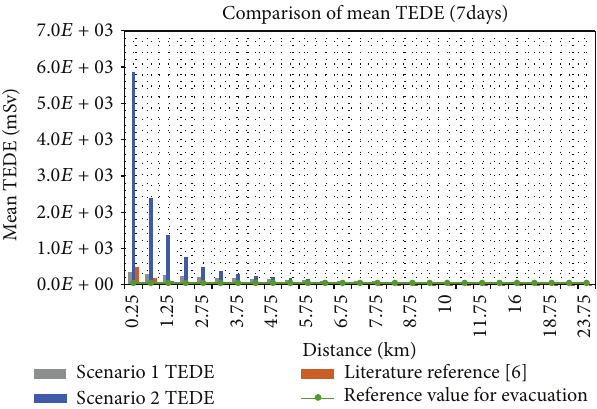
Figure 6: Comparison of mean TEDE (7 days) for constant weather.